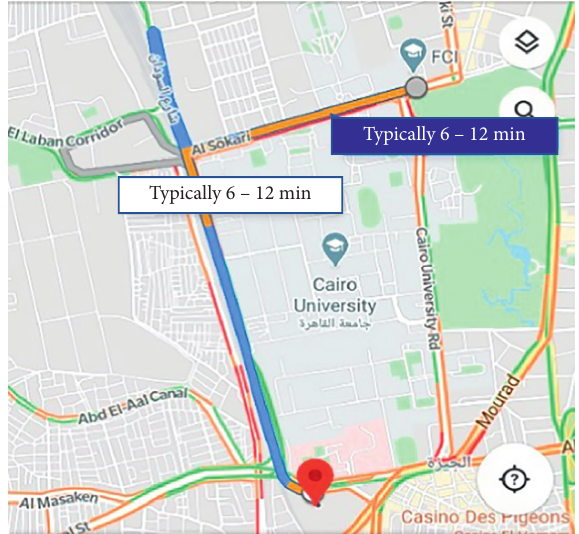
Figure 3: Parameters of the stochastic travelling